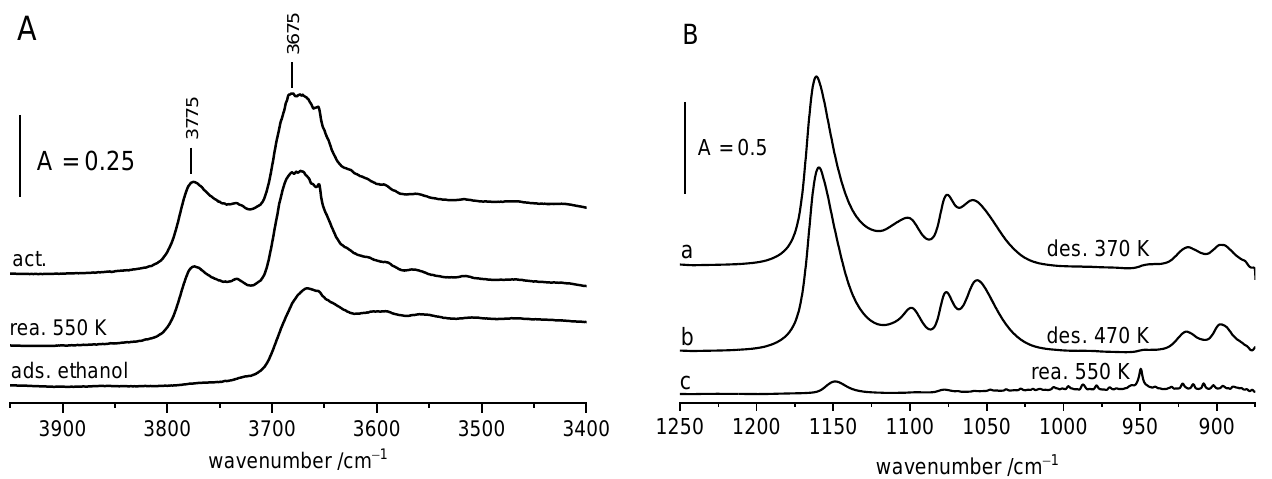
Figure 3. Decomposition of ethoxy groups on ZrO 2 . ( A ) — OH groups on ZrO 2 activated upon the adsorption of ethanol (ca. 30 µmol of ethanol/100 mg ZrO 2 ) and upon the reaction of adsorbed ethanol at 550 K. ( B ) — ethoxy groups on ZrO 2 upon desorption at 370 K (a) and at 470 K (b), as well as upon reaction at 550 K (c). All the spectra were recorded at RT.